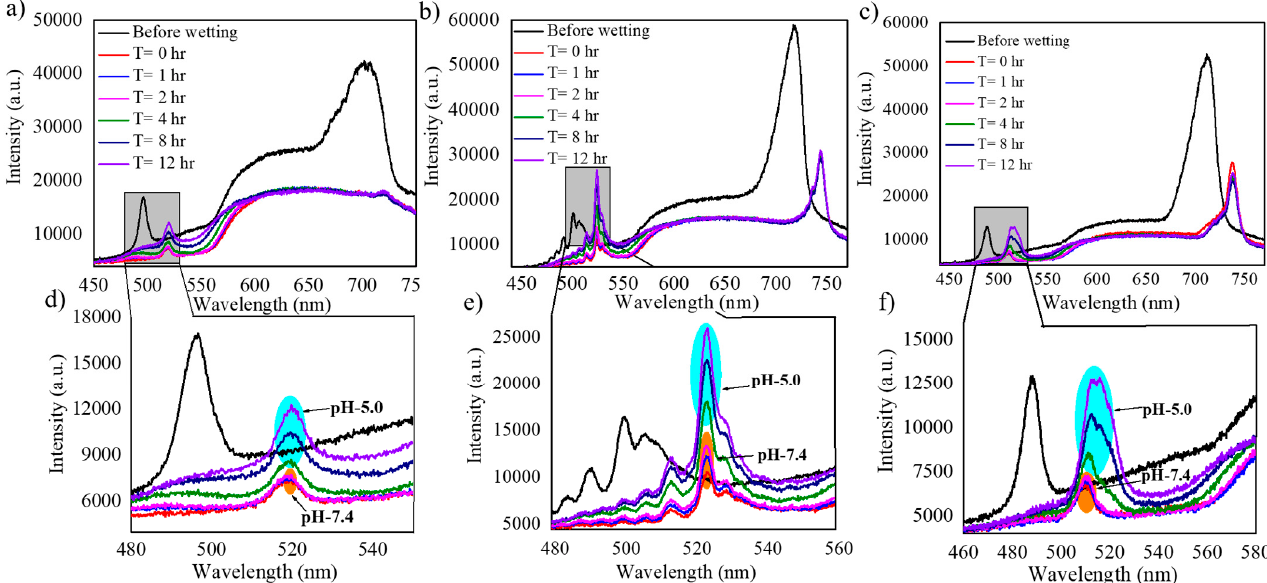
Figure 9. Intensity spectra obtained in the flow cell setup and under two pH conditions (5.0 and 7.4) for NAA-GIFs fabricated with a varying number of periods. ( a ) N = 150, ( b ) N = 200, ( c ) N = 250. ( d – f ) represent the magnified view of the signal stopband for the data in ( a – c ), respectively.